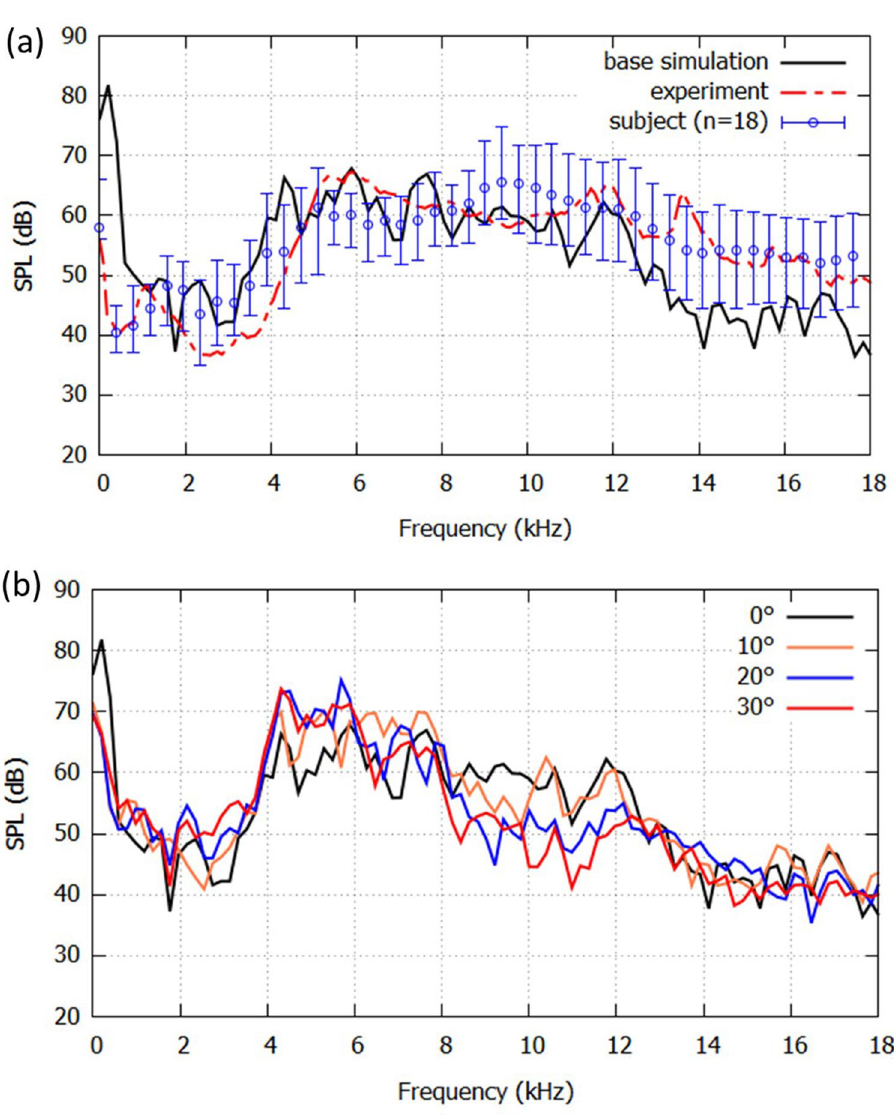
Figure 4. ( a ) Sound pressure level (SPL) spectrum of the base simulation (0°, solid black line) and measurements of the printed replica (dashed red line) and the average value of an actual subject for 18 recordings (blue circles). The error bars denote the range for 18 repeated recordings. ( b ) The predicted SPL spectra with incisor angles from 0° to